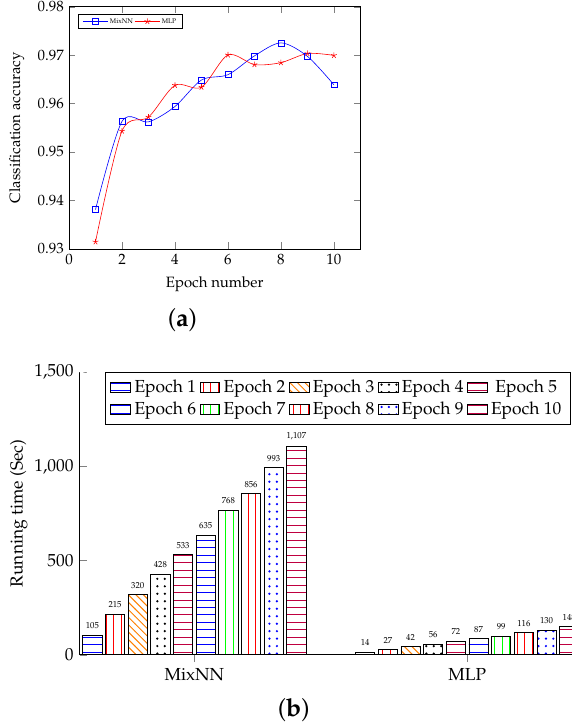
Figure 3. Classification accuracy and running time compared MixNN with MLP. ( a ) Classification accuracy compared Mix-NN with MLP. ( b ) Running time compared MixNN with